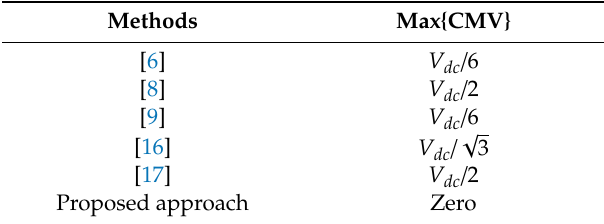
Figure 18. E ffi ciency analysis in terms of switching frequency. Figure 18. Efficiency analysis in terms of switching frequency. Figure 18. Efficiency analysis in terms of switching frequency. Table 6. Measured maximum Table 6. Measured maximum CMV. Table 6. Measured maximum CMV.